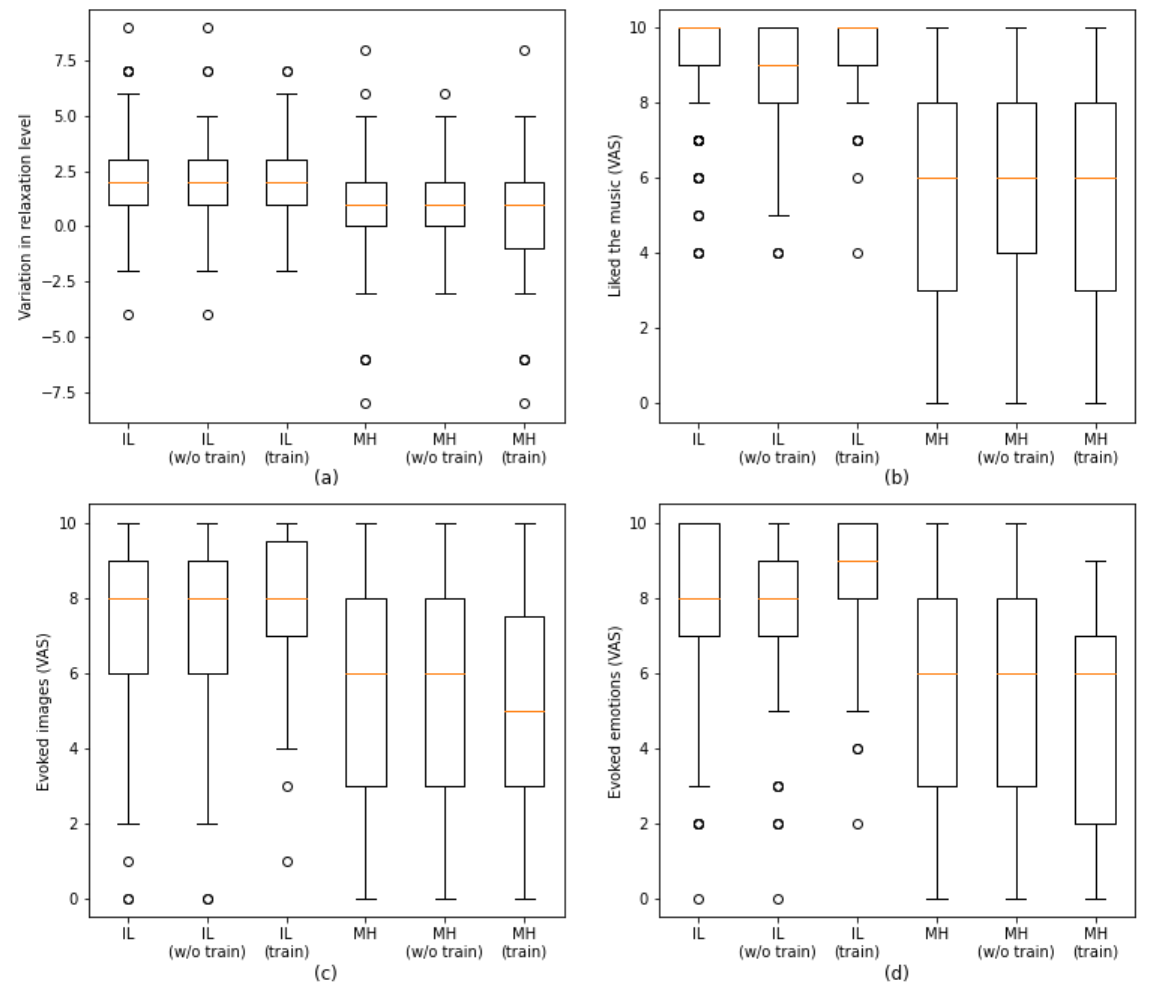
Figure 1. Points of variation in relaxation level ( a ) and enjoying the music ( b ), evoked images ( c ) and evoked emotional levels ( d ) assessed by the Visual Analogue Scale (VAS) in subjects recruited for the study (all, without and with training) in both groups (Individualized Music Listening Group = IL and Melomics-Health Group = MH). On each box, the central mark is the median, the edges of the box are the 25th and 75th percentiles, and the whiskers extend to the most extreme data points that are not considered